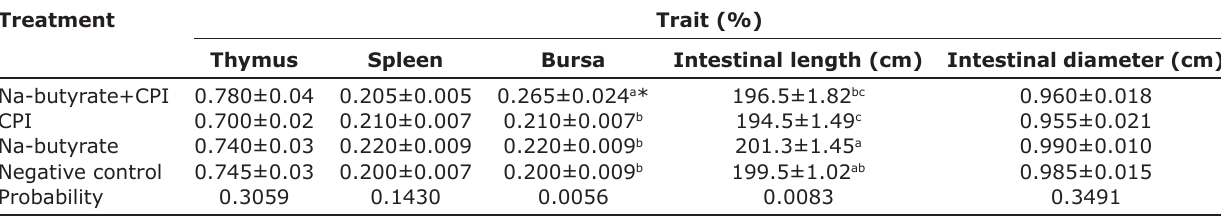
Table-4: Effect of Na-butyrate feed supplementation on relative weights of thymus, spleen and bursa of Fabriciusand intestinal length and diameter of CPI and non-infected broilers. Treatment